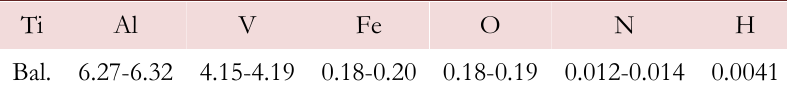
Table 1: Chemical composition of Ti-6Al-4V alloy (wt.%).